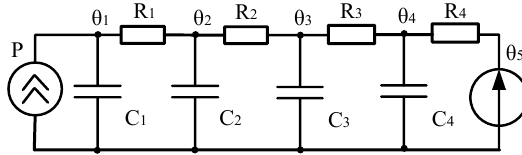
Figure 1 . Thermal equivalent